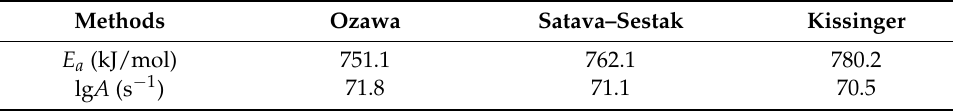
Figure 9. The E O curves of pyrolysis vs. degree of reaction created by the Ozawa method. According to the g ( α ) obtained by computational screening, the apparent activation energy and pre-exponential factor at the peak temperature were calculated using the Ozawa method and the Satava–Sestak method, respectively, as shown in Table 3. The apparent activation energy and the pre-exponential factor at the peak temperature calculated by the three methods were relatively close, and the calculated results were accurate. Table 3. E a and lg A calculated by the three methods.